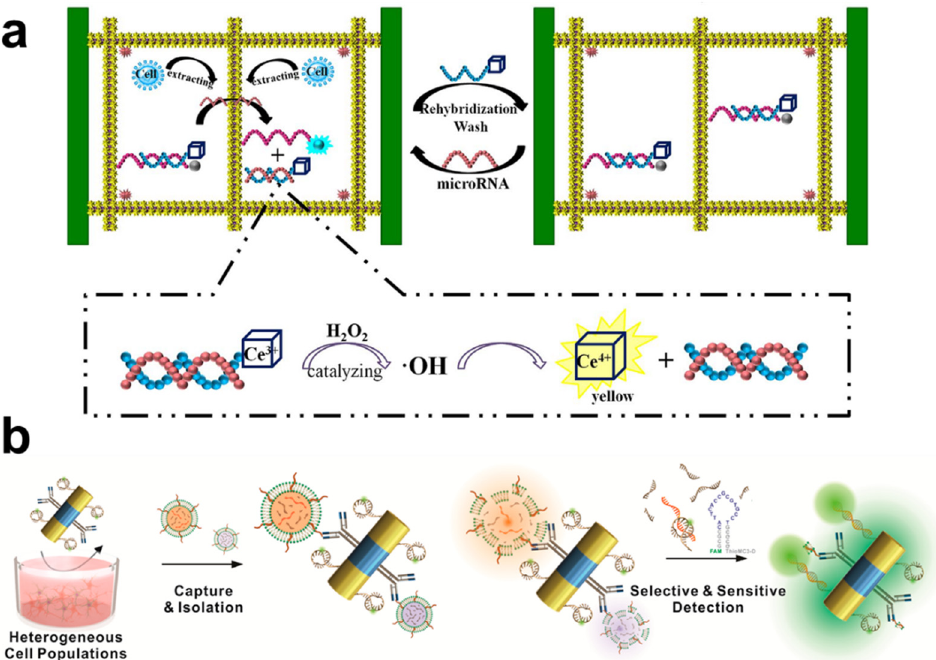
Figure 5. MEF-based RNA nanobiosensors. ( a ) Schematic diagram of the Au-based triangular nanoprism biosensor for detection of miRNAs via the SERS and MEF methods. This figure is reproduced from [94] (© 2017 Elsevier B.V.); ( b ) Schematic illustration of exosomal miRNA detection by using multifunctional Au-Ni-Au nanorods via the MEF effect. This figure is reproduced from [98] (© 2019 American Chemical Society).